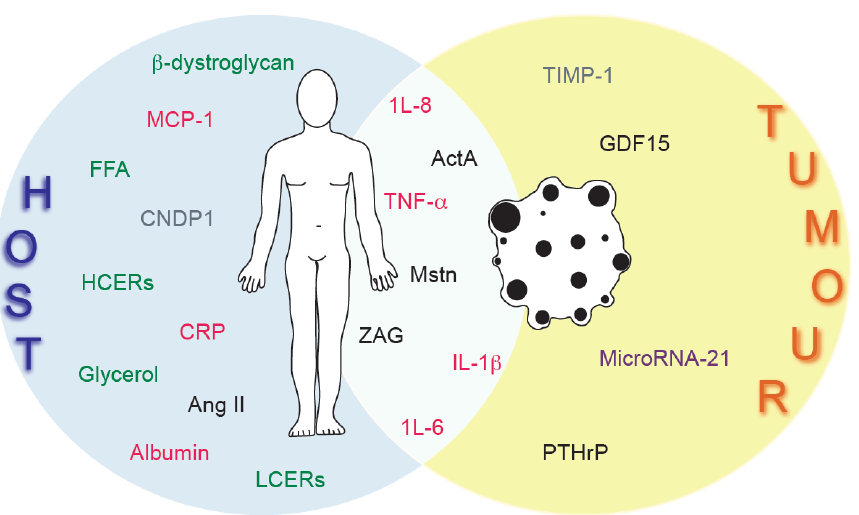
Figure 1. Sources of cancer cachexia biomarkers. Cancer cachexia biomarkers originate from the host, the tumor, or both. Cachexia inducing biomarkers are shown in black, inflammatory markers in red, muscle and fat wasting products in green, microRNAs in purple, and other factors in grey. MicroRNAs 203 and 130a are not included as the source is unknown.